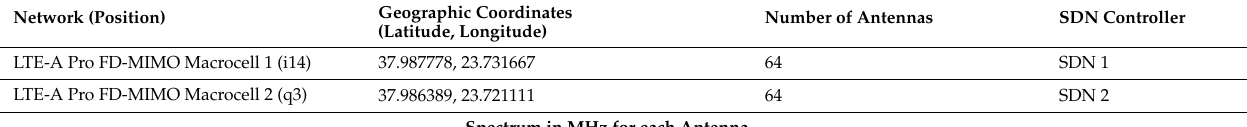
Table A1. The positions and the frequencies of the available LTE-A Pro FD-MIMO